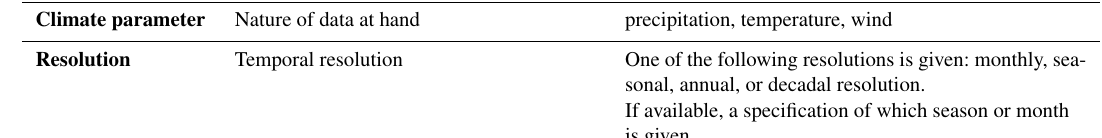
Table 2. Overview of all the meta-information that is available for every entry in the